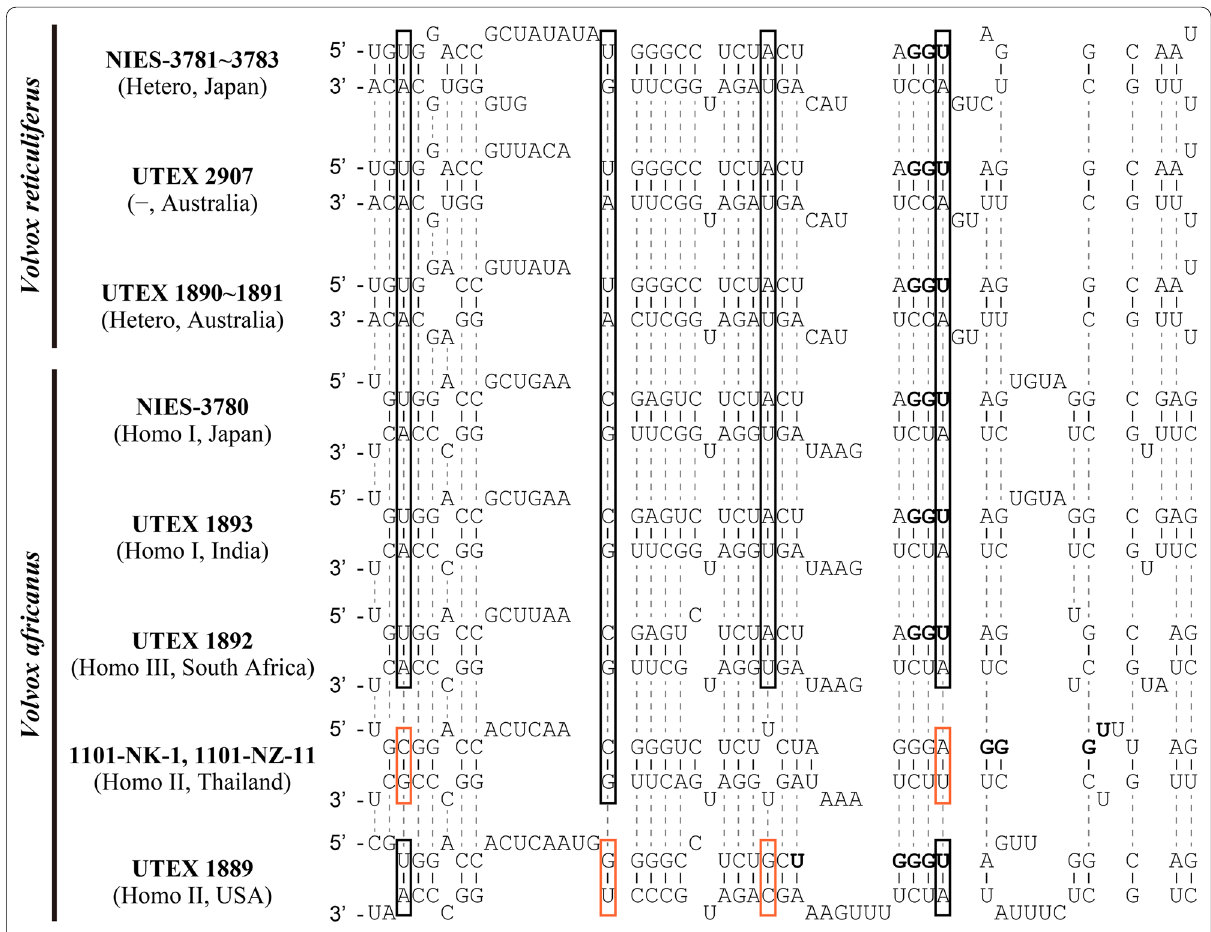
Fig. 6 Comparison of the most conserved region [near the YGGY motif of helix III (Coleman 2009)] of nuclear rDNA ITS-2 secondary structure between strains of four mating systems of Volvox africanus and V. reticuliferus (Table 1). Note the modified YGGY motif (boldface). For secondary structures of ITS-2, see Nozaki et al. (2015a). Red and black open boxes indicate compensatory base changes between Homo II strains (from Thailand and USA) and those of other sexual